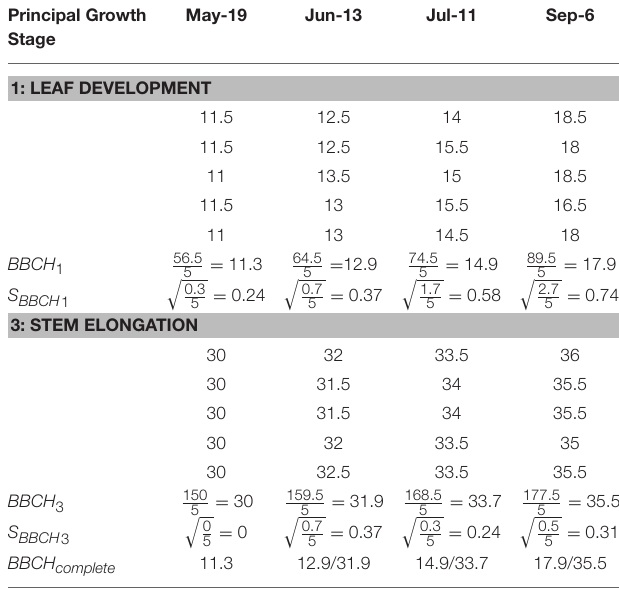
TABLE 4 | Explanatory data showing the principal growth stages (1 = leaf development and 3 = stem elongation) and secondary growth stages of five Miscanthus × giganteus stems over four sampling dates in 2016 in Sorenson farm,